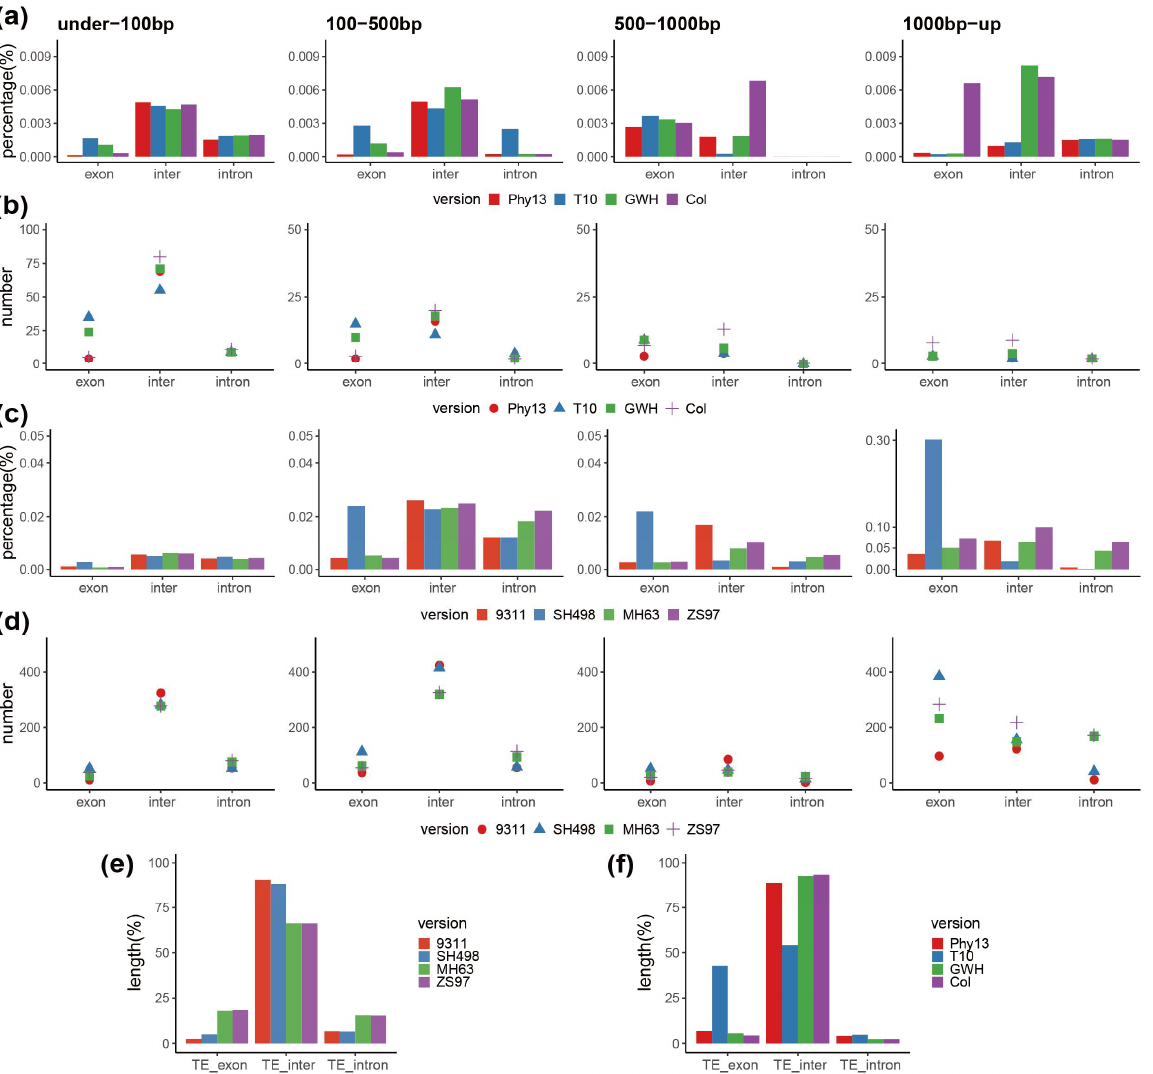
Figure 3. Differences in plastome-to-nuclear genome IGT between different assembly versions in O. sativa and A. thaliana . ( a ) The length proportion of A. thaliana plastome inserts to each genic region in the category with identity ≥ 95%. ( b ) The number of A. thaliana plastome inserts to each genic region in the category with identity ≥ 95%. ( c ) The length proportion of O. sativa plastome inserts to each genic region in the category with identity ≥ 95%. ( d ) The number of O. sativa plastome inserts to each genic region in the category with identity ≥ 95%. Exon refers to the exon region of an anno- tated gene, intron refers to the intron region of an annotated gene, and inter refers to the intergenic regions between annotated genes. ( e ) TE content of O. sativa plastome inserts to each nuclear genic region in the category with identity ≥ 95%. ( f ) TE content of A. thaliana plastome inserts to each nuclear genic region in the category with identity ≥ 95%. 4. Discussion 4.1. IGT Occurs Continuously and Can Be Detected More Accurately with Improved Genome Assembly IGT from the plastome to the nuclear genome is a dynamic and ongoing pro- cess[30,47,48]. Many such transfers have been reported in numerous studies, such as the